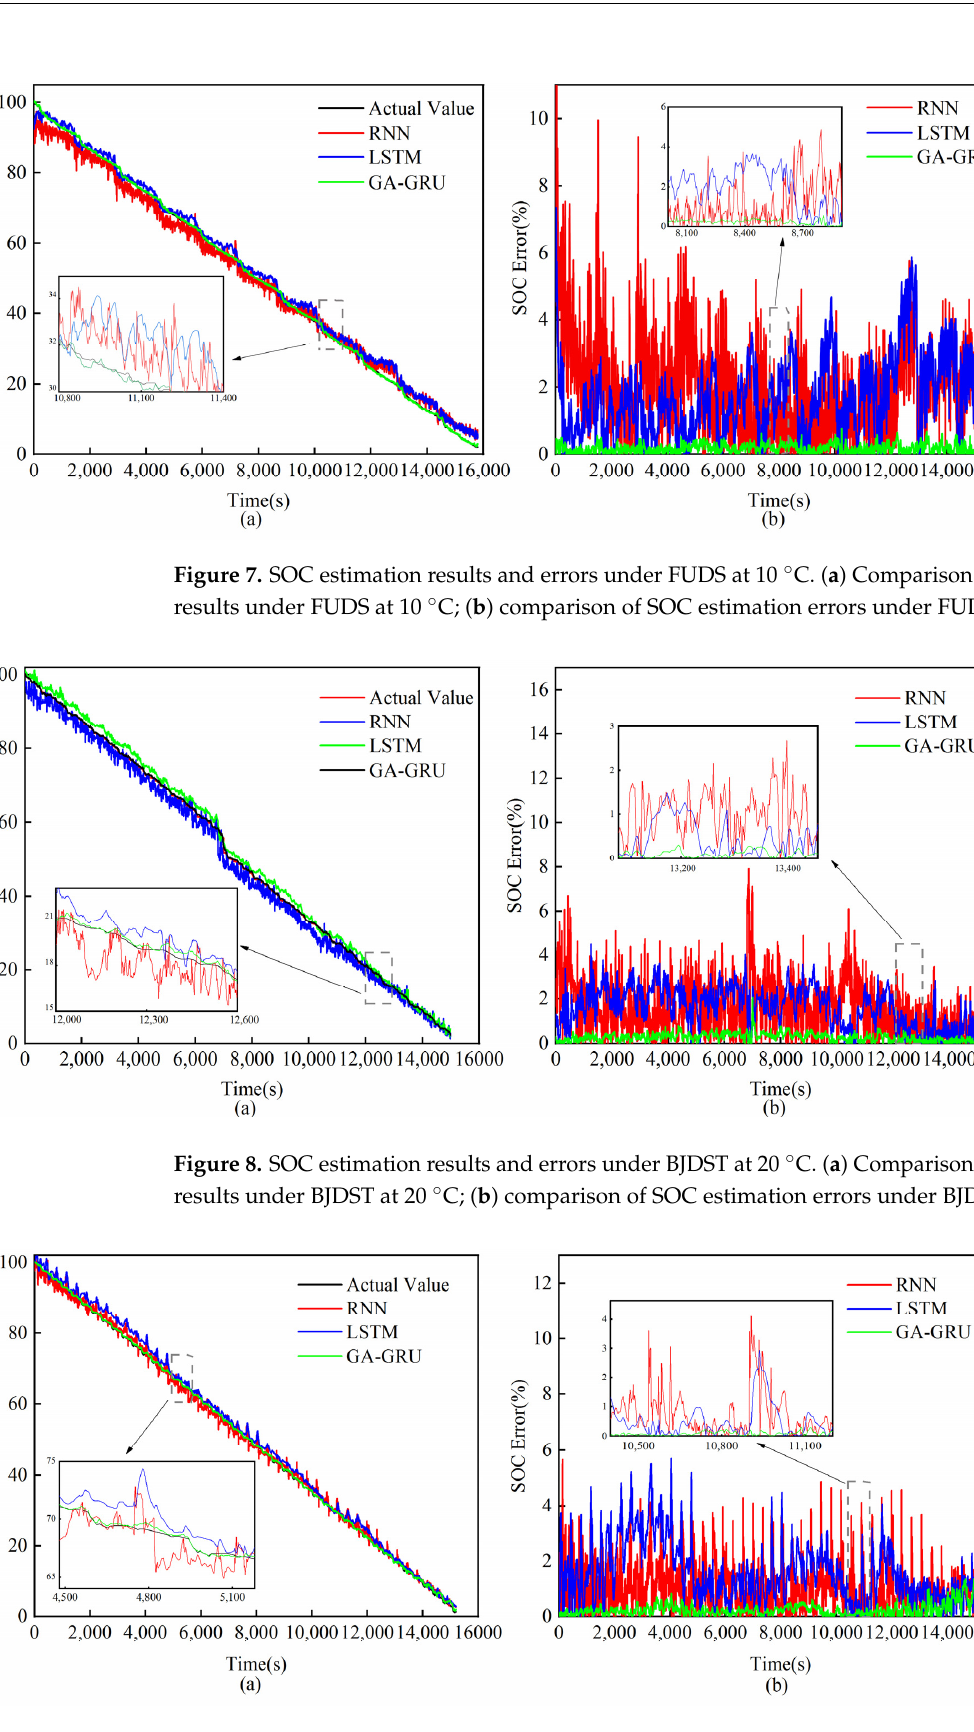
Figure 9. SOC estimation results and errors under DST at 30 °C. ( a ) Comparison of SOC estimation results under DST at 30 °C; ( b ) comparison of SOC estimation errors under DST at 30 °C.